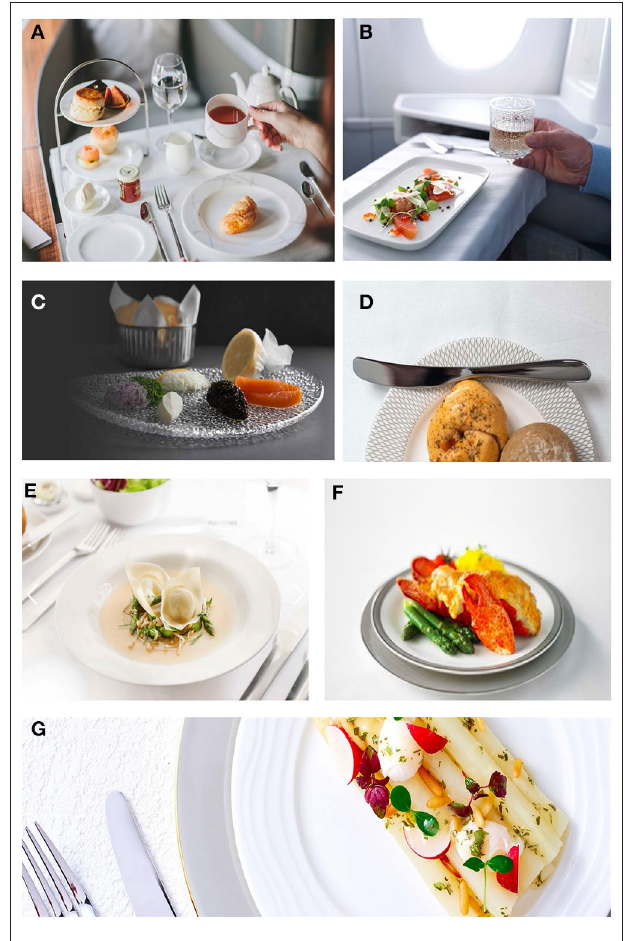
FIGURE 3 | Montage of visual extracts from seven different airline websites; extracts numbered clockwise from top left (A) airline#2, (B) airline#4, (C) airline#8, (D) airline#10, (E) airline#11, (F) airline#9, and (G)